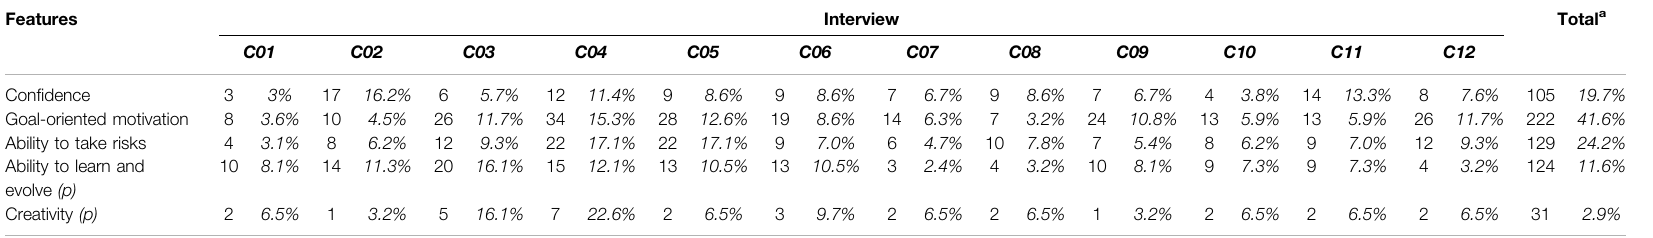
TABLE 4 | Personal features quotes.